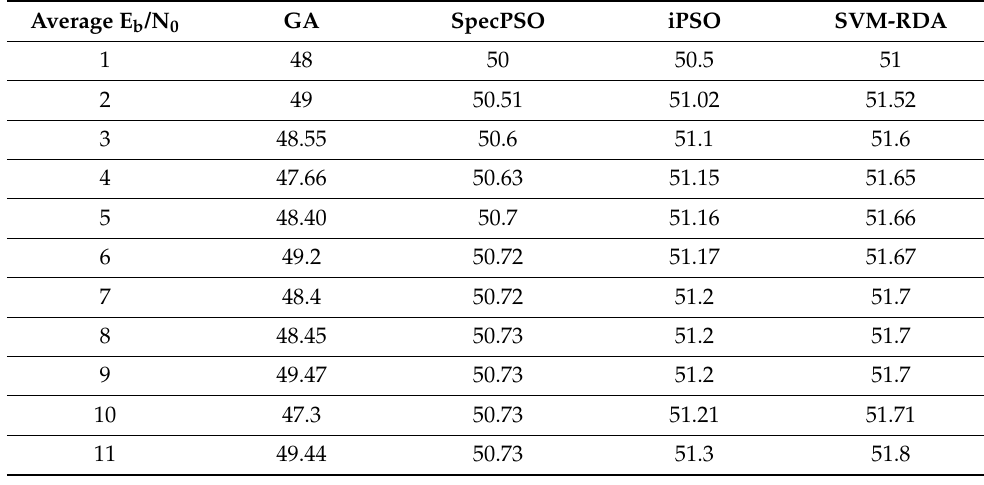
Table 4. Comparison of the SNR on different average E b /N 0 values for various handoff algorithms. Average E b /N 0